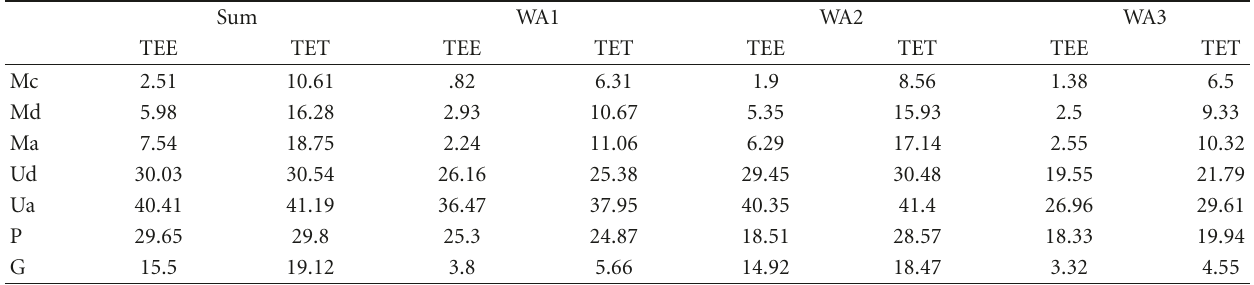
Table 4: Fusion results for the di ff erent BANCA protocols using di ff erent fusion